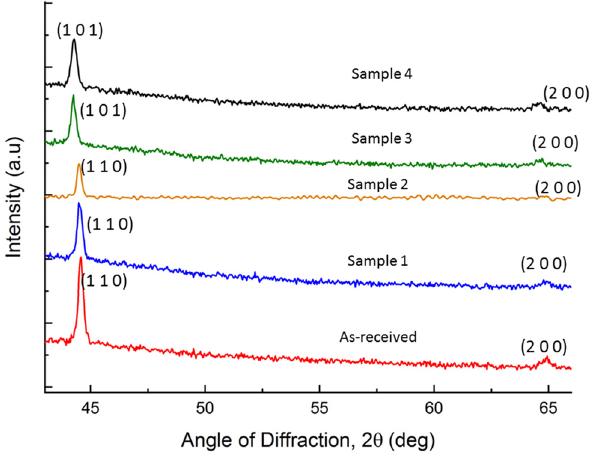
Figure 8: XRD spectra at the various re fl ecting planes of the as - received and machined surface under various cutting conditions.